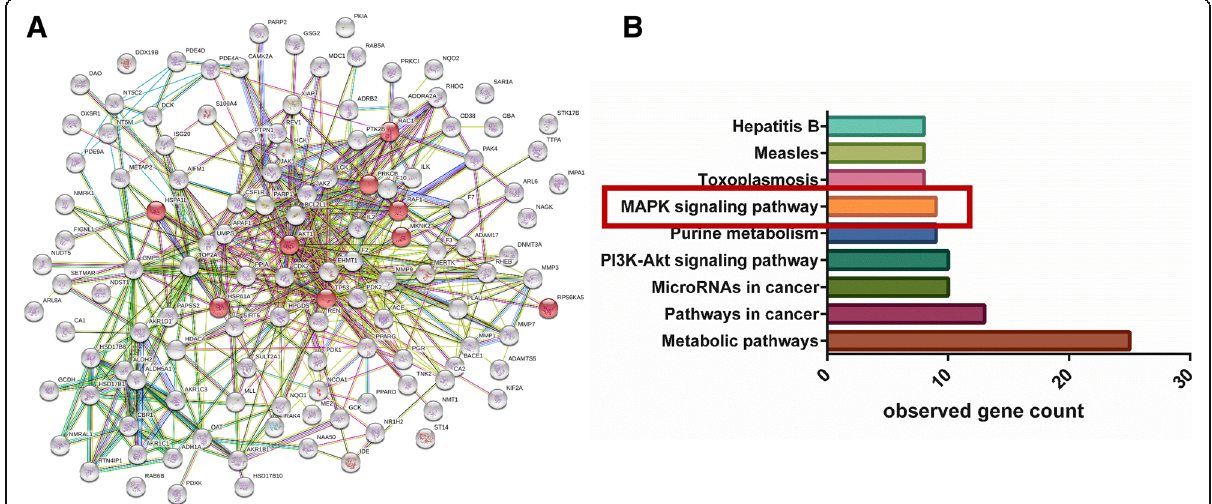
Fig. 3 Network pharmacology analysis through the protein interaction of predicted protein targets ( a ) and signaling pathways ( b ) of representative ingredients of TRX. The network nodes were predicted proteins and the edges represented the functional associations. The red